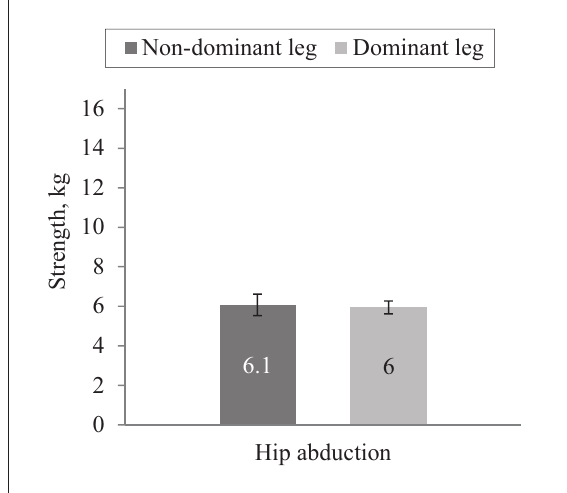
Figure 5. Change in the strength (kg) of muscles of the dominant and non-dominant leg of the female athletes after the hip abduction